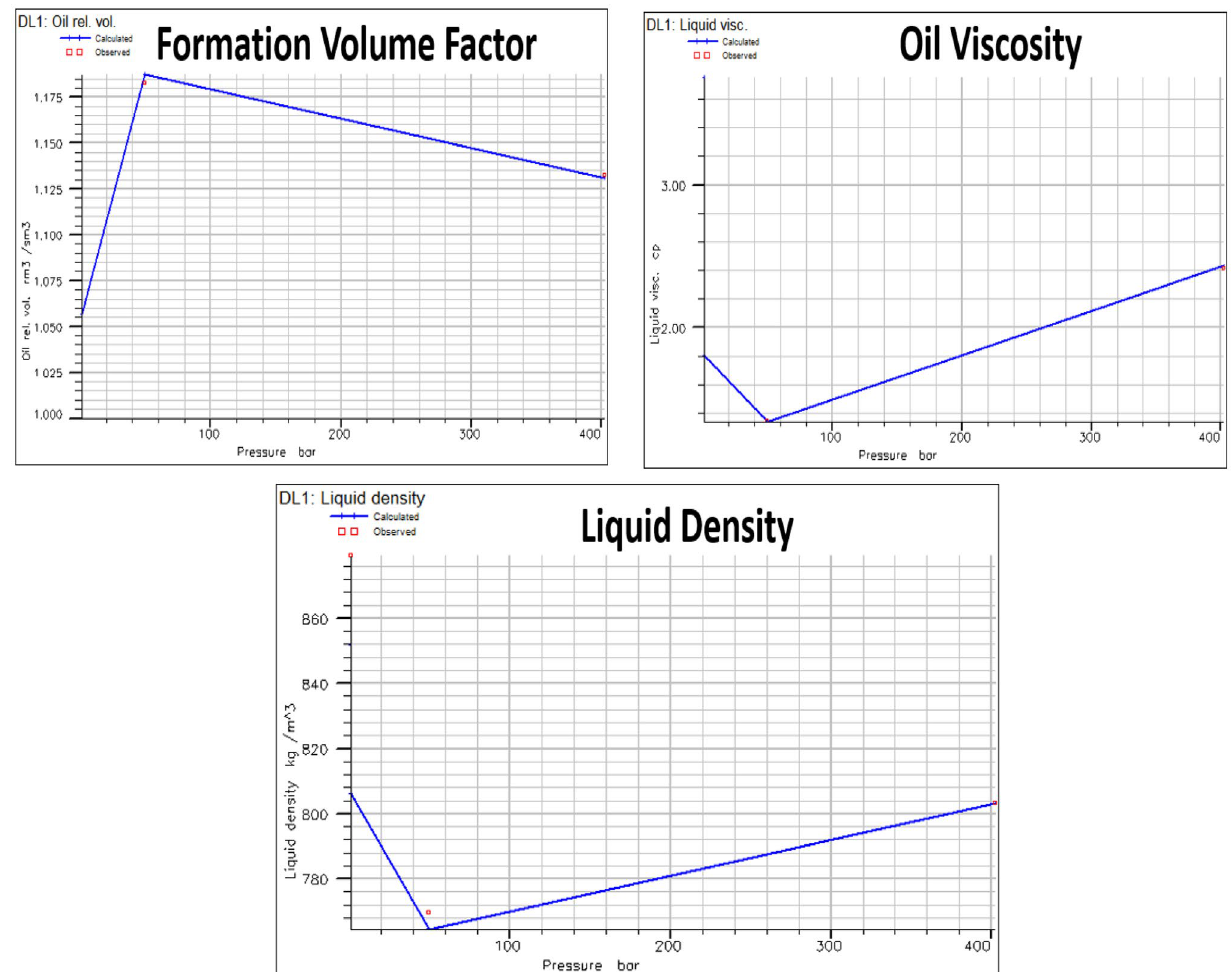
Fig. 3 Summary of matching result of key PVT